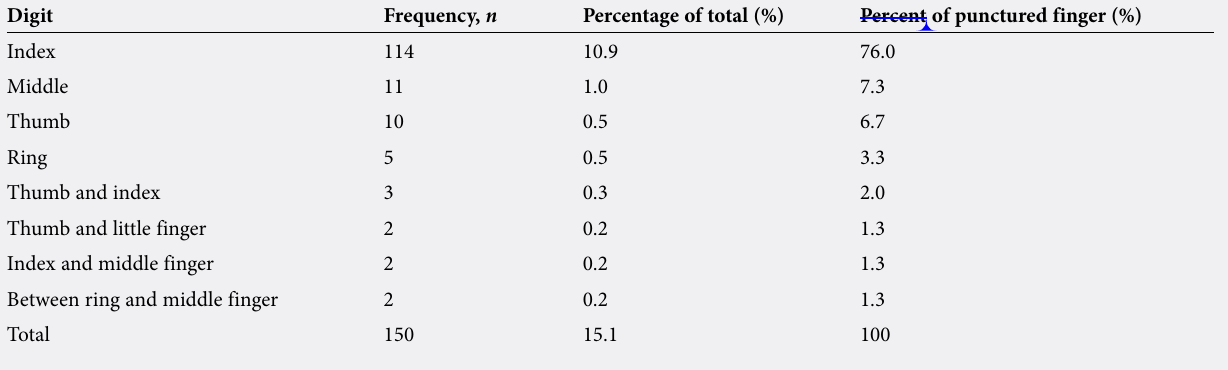
Table 5. Digits most frequently involved in the puncture